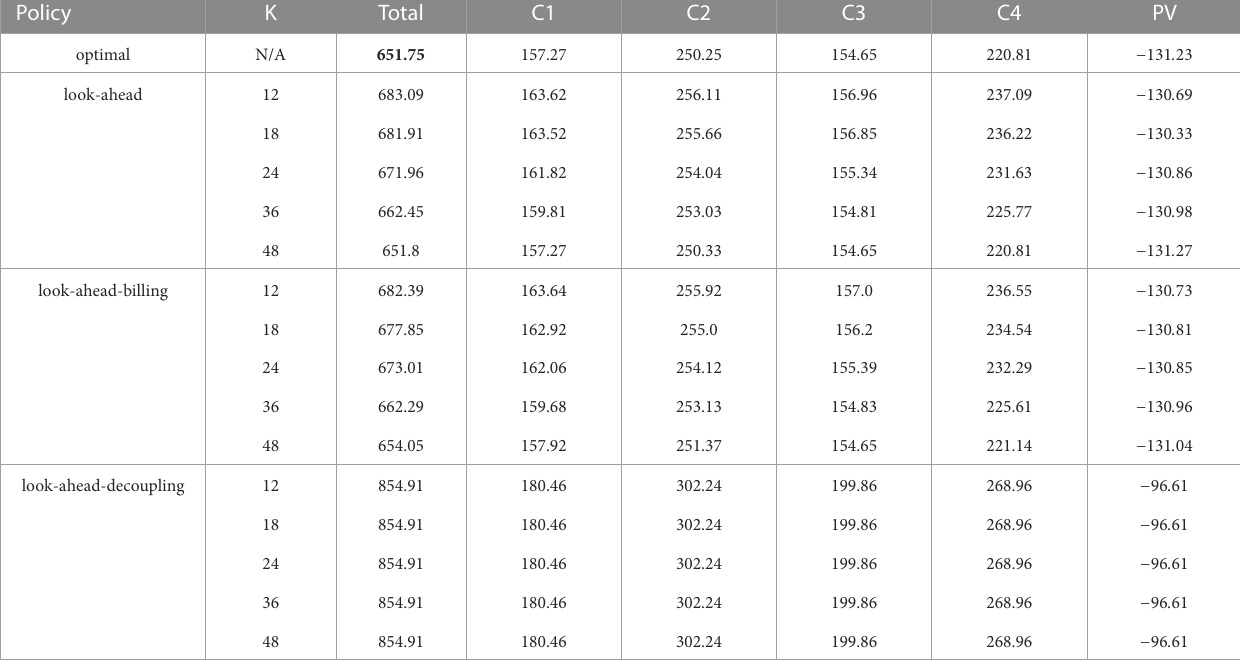
TABLE4 Size(infinancialterms)oftheelectricitybillintotalandalsoforeachmemberbytestingthethreepolicieswithseveralpolicyhorizonsforthefirstREC, comparedwiththe optimal policy(equivalenttothelook-aheadpolicywith K = T = 720 ).Sincethesizeoftheelectricitybillofthemember6is0regardlessofthe